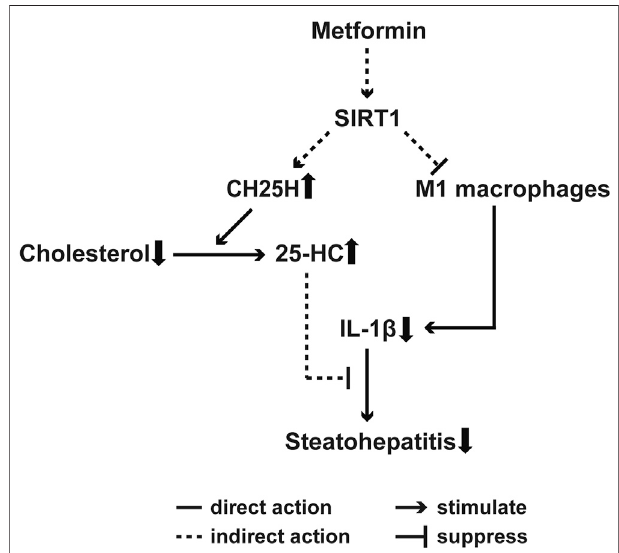
FIGURE 7 | Proposed mechanism for metformin-alleviated steatohepatitis. A SIRT1-dependent cholesterol catabolism and M1 macrophages polarization are involved in metformin-induced alleviation of steatohepatitis in DIO mice. Metformin upregulates CH25H and may result in increased level of 25-HC, which has been reported to inhibit IL-1 β - driven in fl ammation, thus ameliorates hepatic in fl ammation. On the other hand, metformin also downregulates the M1 macrophage markers, which suggests that metformin may inhibit the M1 macrophages polarization to alleviate steatohepatitis. Importantly, SIRT1 de fi ciency impairs the bene fi cial effects of metformin on